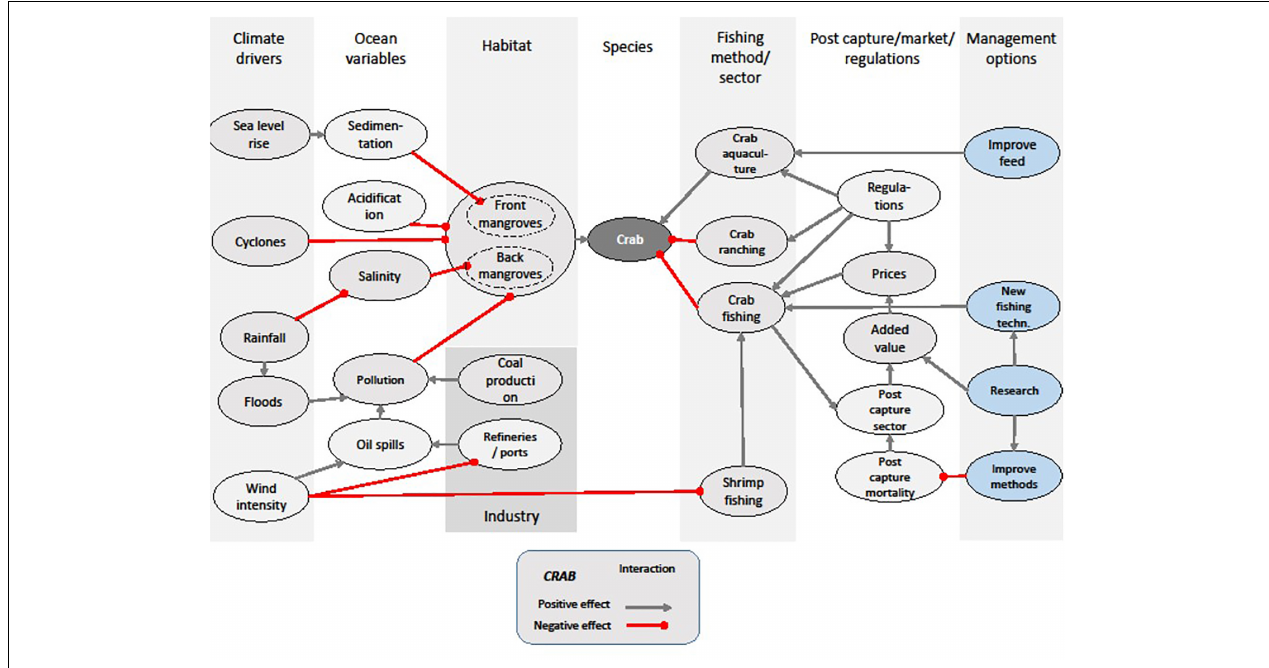
FIGURE 6 | Conceptual model of the crab fishery developed by participants at the Antananarivo